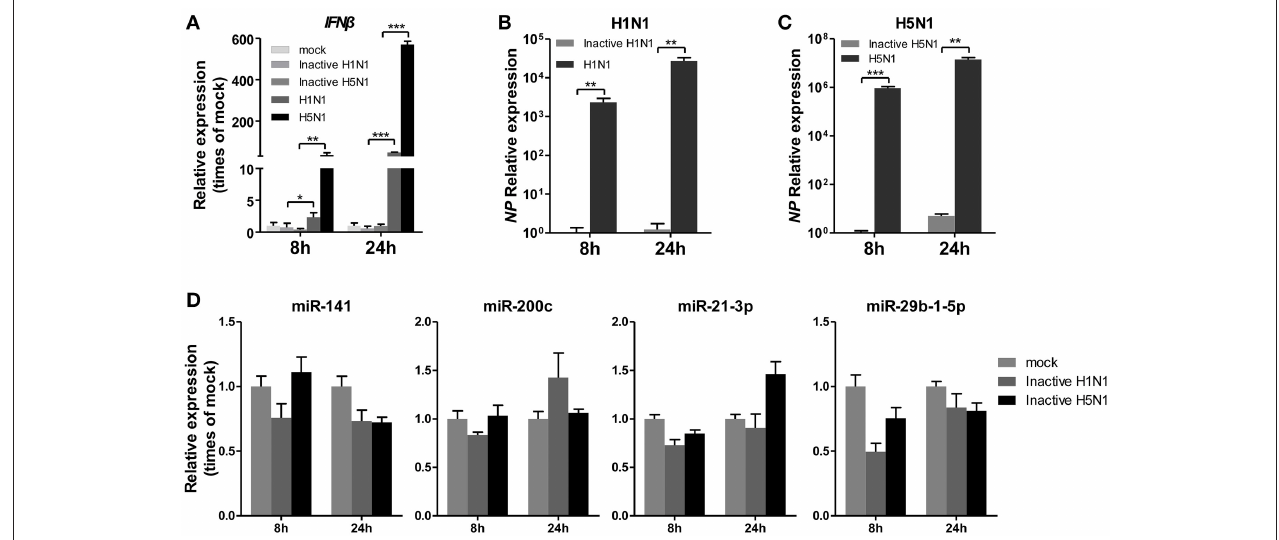
FIGURE 3 | UV-irradiated IAV does not regulate expression of miRNAs. A549 cells were inoculated with UV-irradiated H1N1 and H5N1 at a MOI of 5.0 for the indicated times. (A–C) Expression levels of IFN β and the IAV NP gene were detected by real-time qPCR analysis to confirm the replication of the inoculated virus. Samples were normalized to expression of GAPDH . (D) Expression levels of miR-141, miR-200c, miR-21-3p, and miR-29b-1-5p were determined via real-time qPCR. Samples were normalized to expression of U6 snRNA and relative to mock-infected cells. Data are the mean ± SD of triplicate samples from a single experiment and are representative of two independent experiments. * P < 0.05, ** P < 0.01 and *** P < 0.001 by one-way ANOVA or t -test.